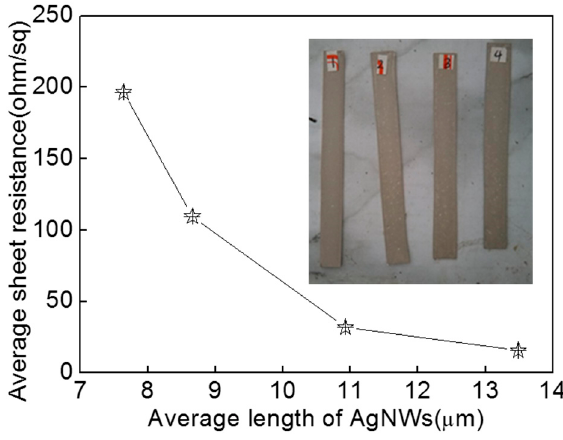
Figure 4. Relationship between average sheet resistance of AgNW coating and length of AgNWs. The inserted image is a photo of samples.